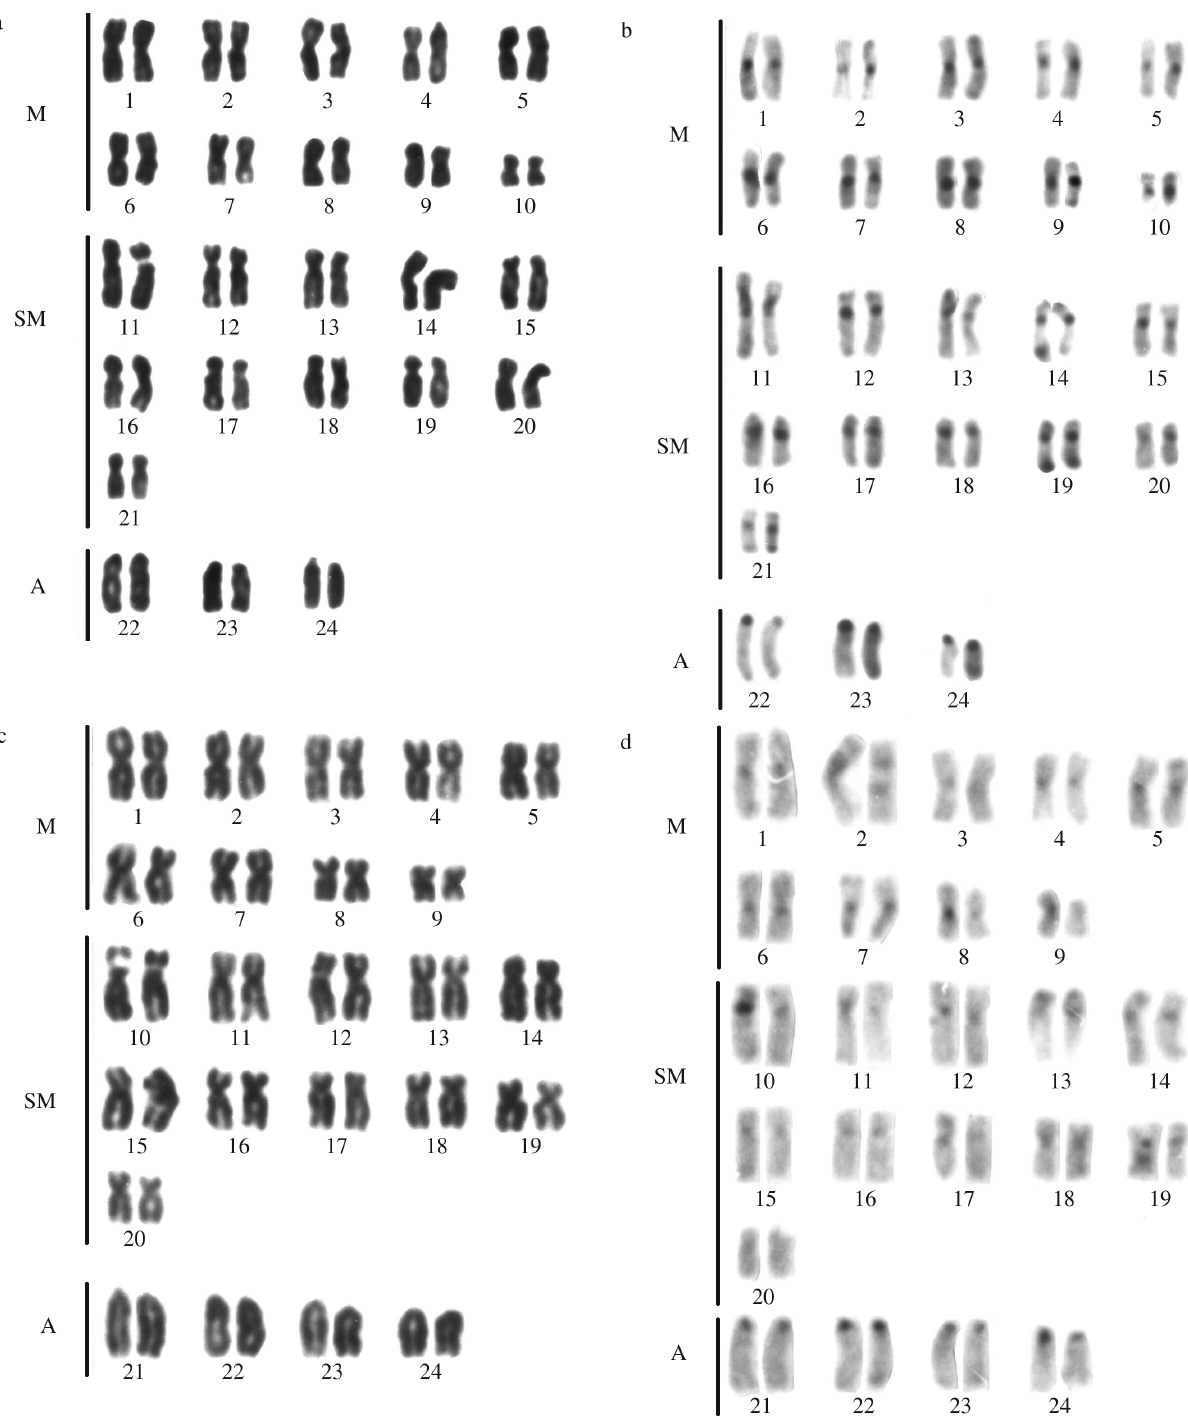
Figure 1 - Karyotypes stained by Giemsa and C banding patterns in (a, b) S. fuscus (2n = 48, FN = 90) and (c, d) S. variabilis (2n = 48, FN = 88). Secondary